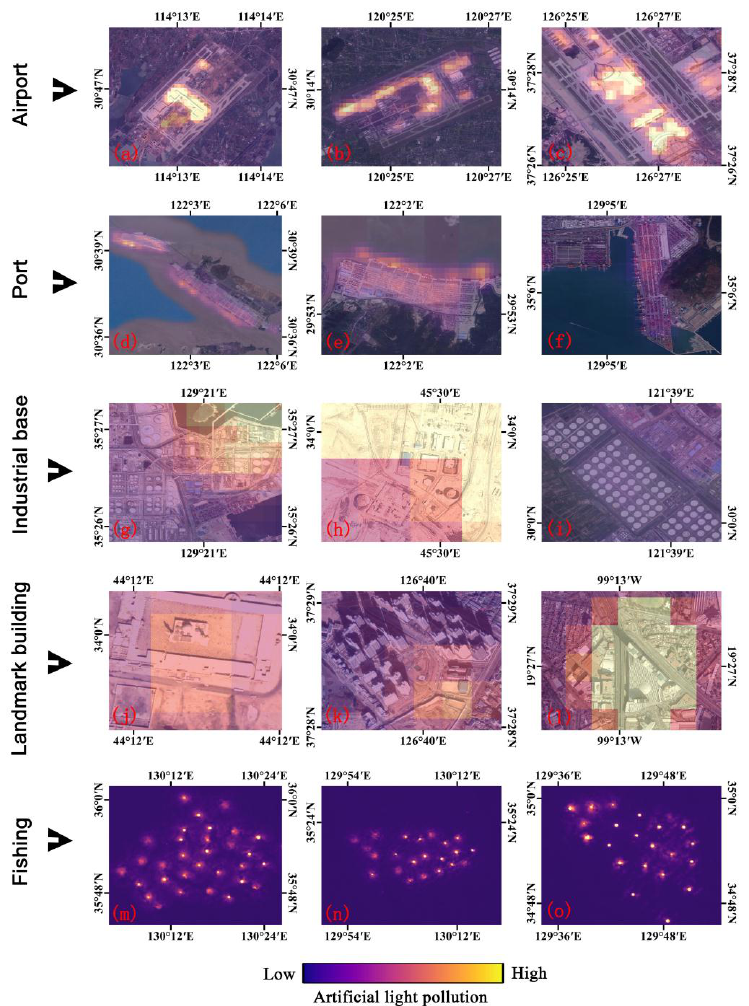
Figure 7. Validation of the high artificial light pollution with high-resolution images: ( a – c ) represent high artificial light pollution in airports; ( d – f ) represent high artificial light pollution in ports; ( g – i ) represent high artificial light pollution in industrial bases; ( j – l ) represent high artificial light pollution in landmark buildings; ( m – o ) represent high artificial light pollution regarding fishing. ( a – l ) are the LuoJia1-01 nighttime light images overlaid on Google Earth high-resolution images with 50% transparency. ( m – o ) are LuoJia1-01 nighttime light